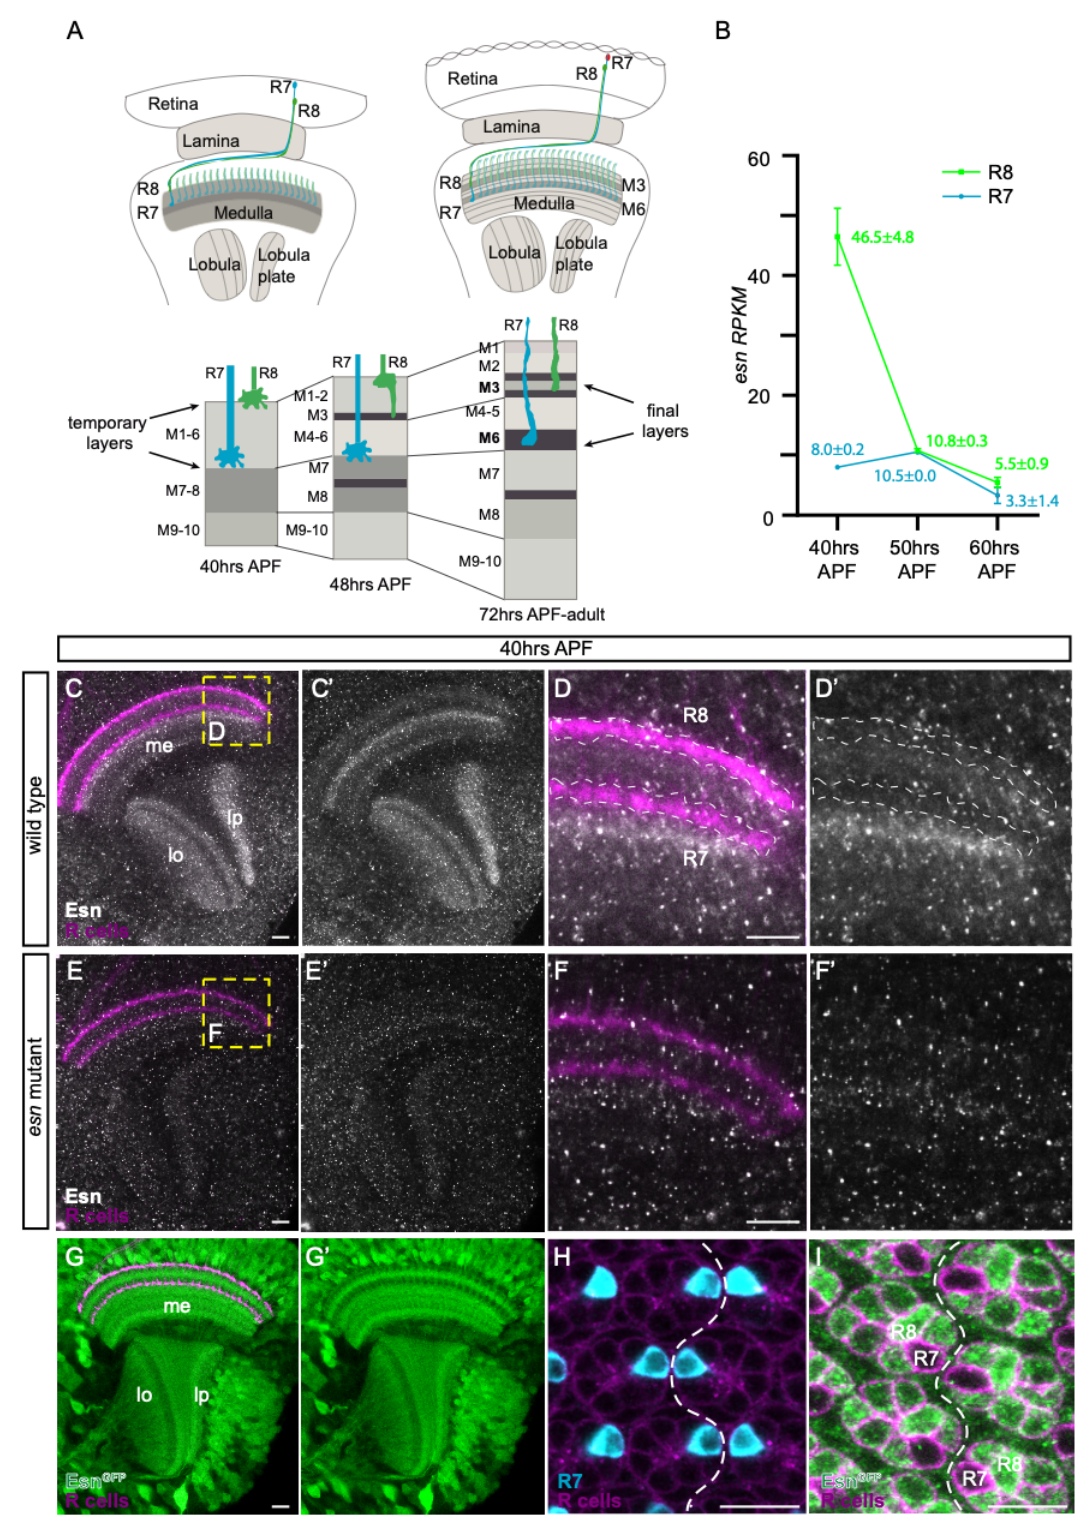
Figure 1. Espinas (Esn) expression in the optic lobe and photoreceptors. ( A ) Schematic showing optic lobes and the photoreceptor array from 40 h after pupal formation (APF) onwards to the adult stage. On the left, the optic lobe at 40 h APF, when all R8 axons (green) sit in their temporary layer at the edge of the medulla. On the right, the optic lobe in the adult stage when all R8 axons have extended to their final target layer, M3. Below, a detail of the medulla showing R8 and R7 layer selection in parallel to layer formation, which at 72 h APF reaches what will be the adult structure. ( B ) Graph showing expression in Reads Per Kilobase Million (RPKM) of esn in the R8 (green) and R7 (cyan)